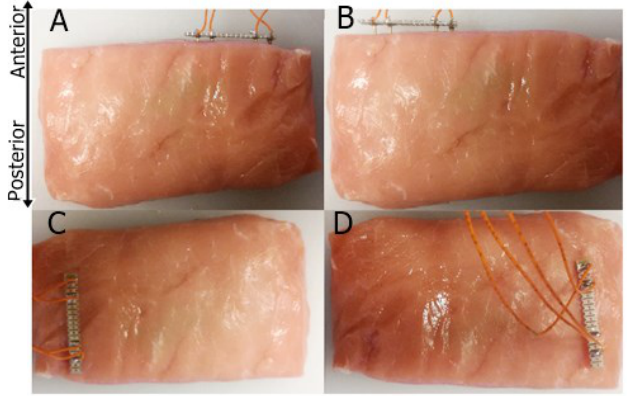
Figure 1: Measuring the bioimpedance of sirloin cuts. Four different positions were chosen for the electrode, two with the electrode inserted perpendicular to the anterior-posterior axis of the LTL (A, B; approximately also perpendicular to the main muscle fiber direction) and two positions along the anterior- posterior axis (C, D; approximately in line with the main muscle fiber direction C, D). The side facing the camera is the dorsal side of the LTL muscle (depicted axes: anterior/posterior &